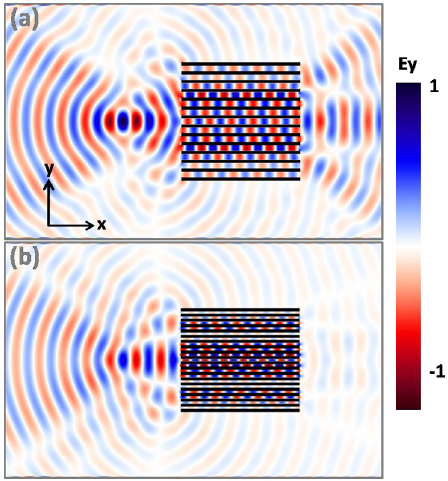
FIG. 4. Finite-difference time domain ( MEEP ) simulation for light transmission through nanochannels of (a) 200 nm and (b) 80 nm hollow channels. The length and width of the targets in (a) and (b) were 4 (cid:1) m (cid:4) 4 (cid:1) m and 4 (cid:1) m (cid:4) 3 : 5 (cid:1) m ,